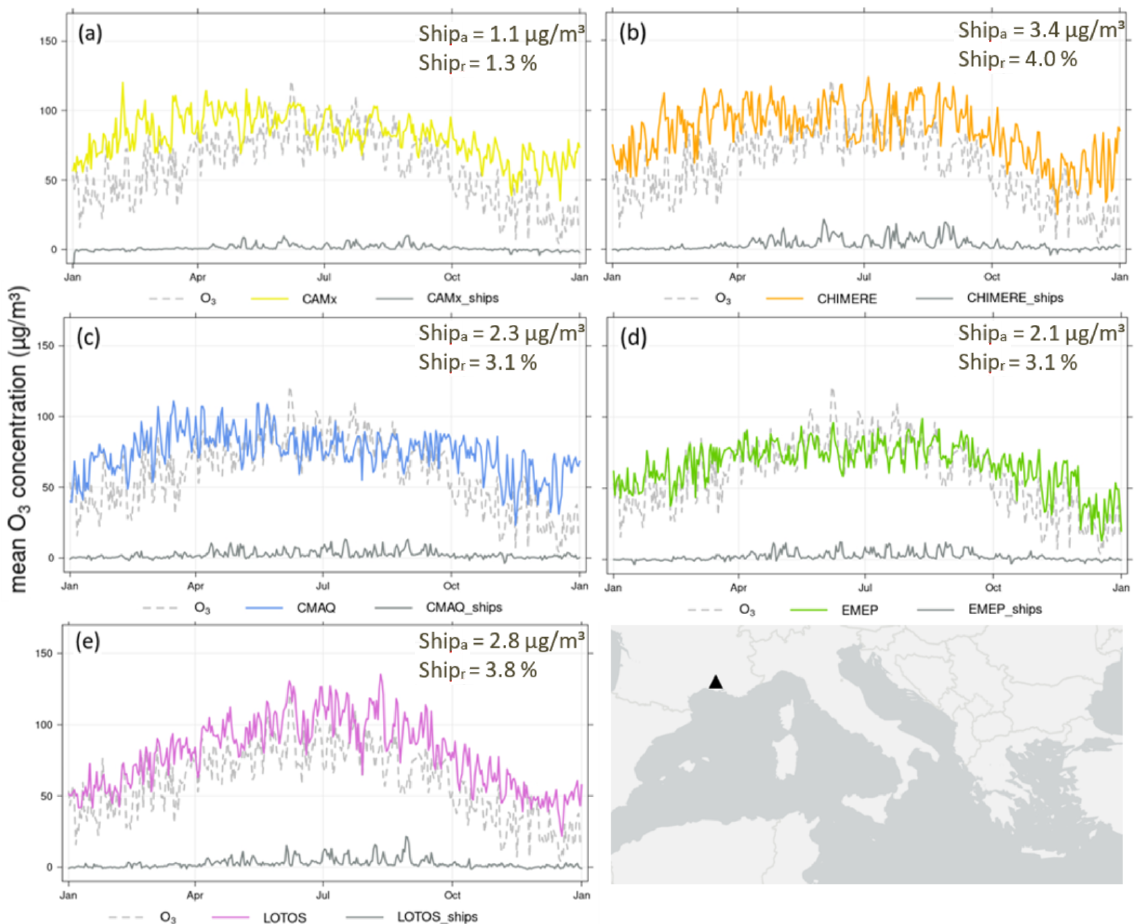
Figure D1. Time series with daily mean O 3 concentration in 2015 at station fr08614 in France. The black triangle on the map (bottom right) displays the location of the station. (a) CAMx; (b) CHIMERE; (c) CMAQ; (d) EMEP; (e) LOTOS-EUROS. Dashed gray line – measured data; colored lines – modeled data; gray line – modeled potential ship impact. Correlation between modeled and measured data for hourly total emission data for 2015: CAMx = 0 . 57; CHIMERE = 0 . 6; CMAQ = 0 . 71; EMEP = 0 . 39; LOTOS-EUROS = 0 . 78. Ship a : potential absolute ship impact; Ship r : potential relative ship impact of the respective